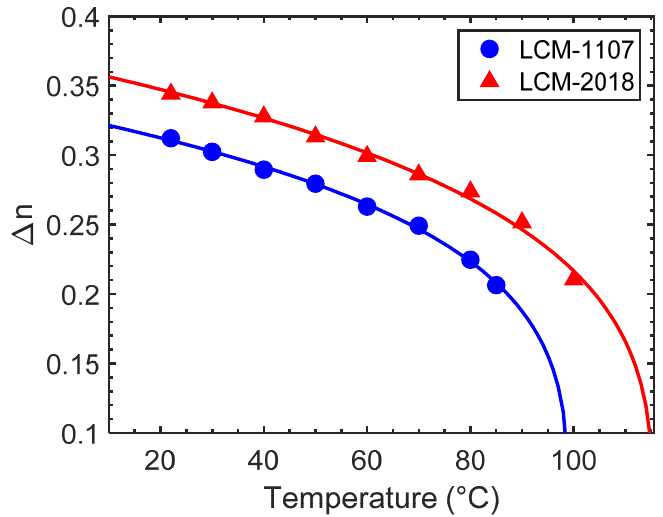
Figure 3. Temperature-dependent birefringence of LCM-1107 and LCM-2018 at λ = 1550 nm and f = 1 kHz. Dots and triangles are measured data and solid lines are fitting curves with Equation (1). In Equation (1), S is the order parameter, T c (unit: K) is the clearing temperature of